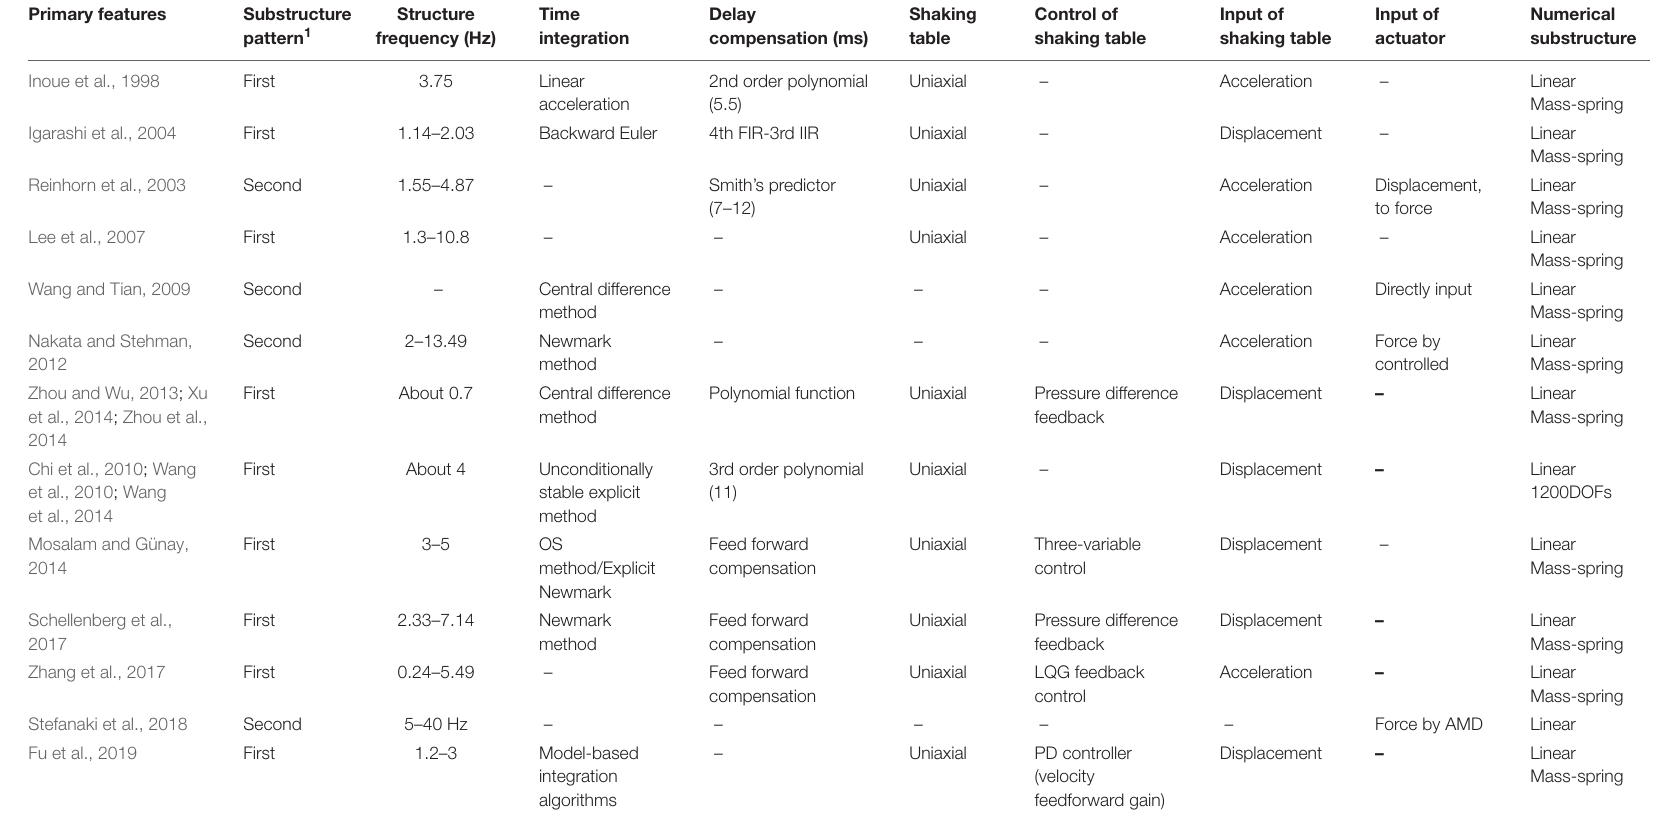
TABLE 1 | Features of existing STST systems and